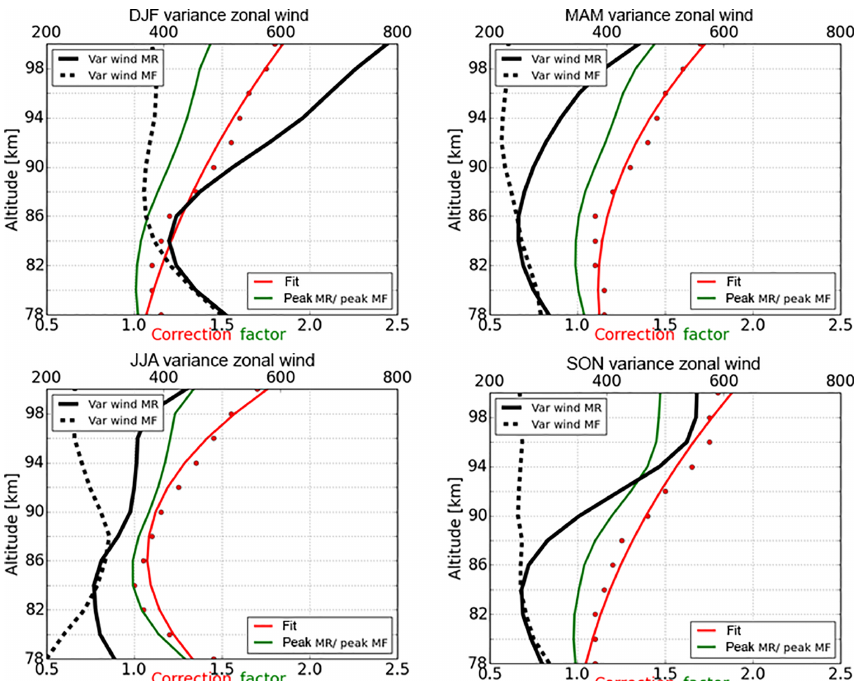
Figure 12. Seasonal plots to adjust the difference in the zonal wind value between the MF and the MR based on two different methods (colored). The correction factor is estimated by sorting the hourly winds according to their values and multiplying the correction factor (CF) on the MF value to get the same shape for the histogram as the MR (see Fig. 11). This is done for every altitude and season manually (red) and by dividing the maximum peak of MR by the maximum peak of MF (green). In black is the variance in the hourly winds for the corresponding season for MF (dashed) and MR (solid) based on hourly wind values over the whole time period for every altitude.